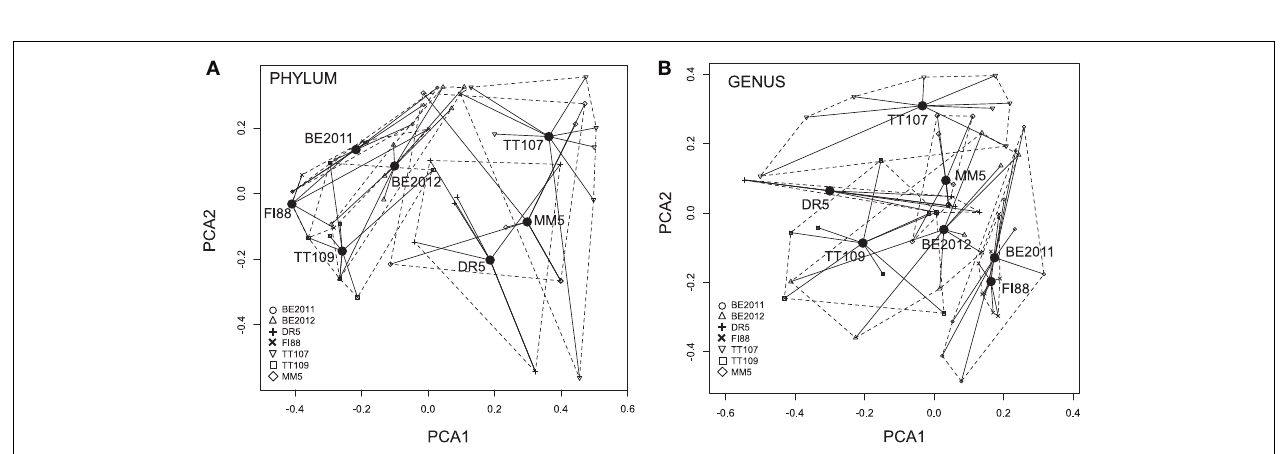
FIGURE 3 | Multi-dimensional scaling plots of dissimilarity in microbial compositions represented by the eight common functional genes within and between metagenomes at the phylum (A) and genus (B) level. Filled circles denote the location of the centroid of each metagenomes. The closer the centroids, the more similar are the taxonomic compositions of the represented metagenomes. Each centroid is joined to the eight common